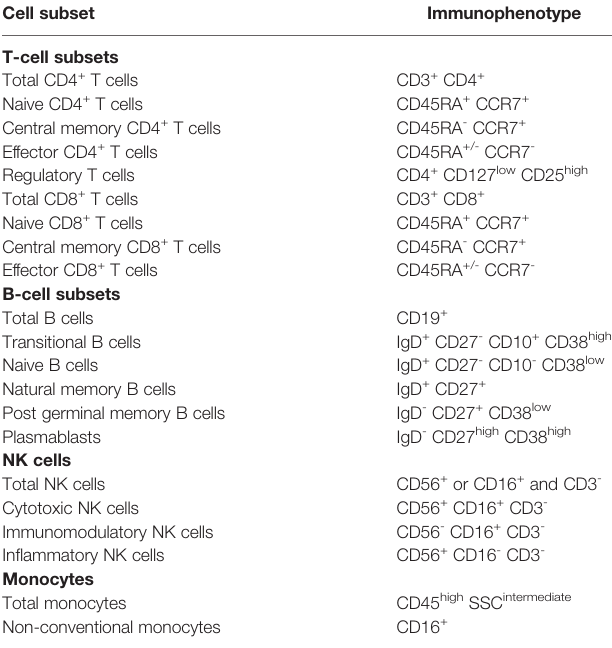
TABLE 2 | Cell subsets and corresponding immunophenotypes.